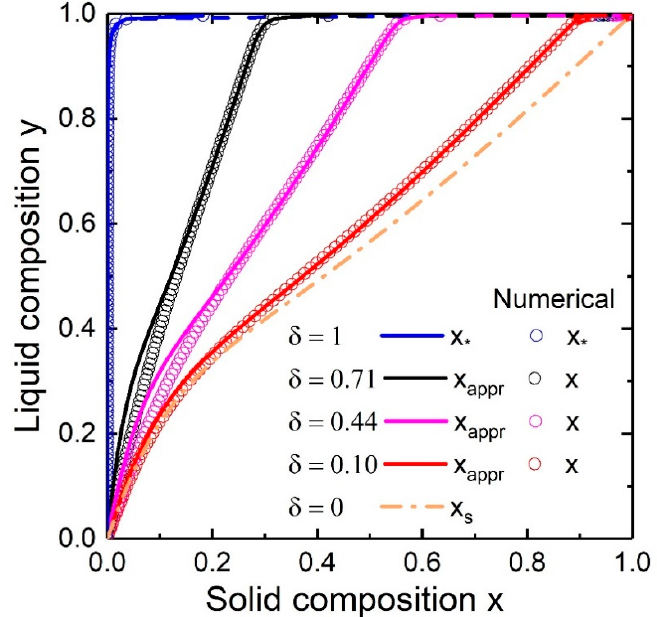
Figure 5. Numerical (circles) and analytical (solid) evolution of the liquid-solid dependence of In x Ga 1 − x As NWs with the size ( δ = 1, 0.71, 0.44, 0.10, 0) at T = 400 ◦ C, c As = 0.02 and c Au = 0.1. Blue solid and ginger dash-dotted curves correspond to nucleation limited and kinetic composition dependencies respectively. Dashed lines indicate miscibility gaps.